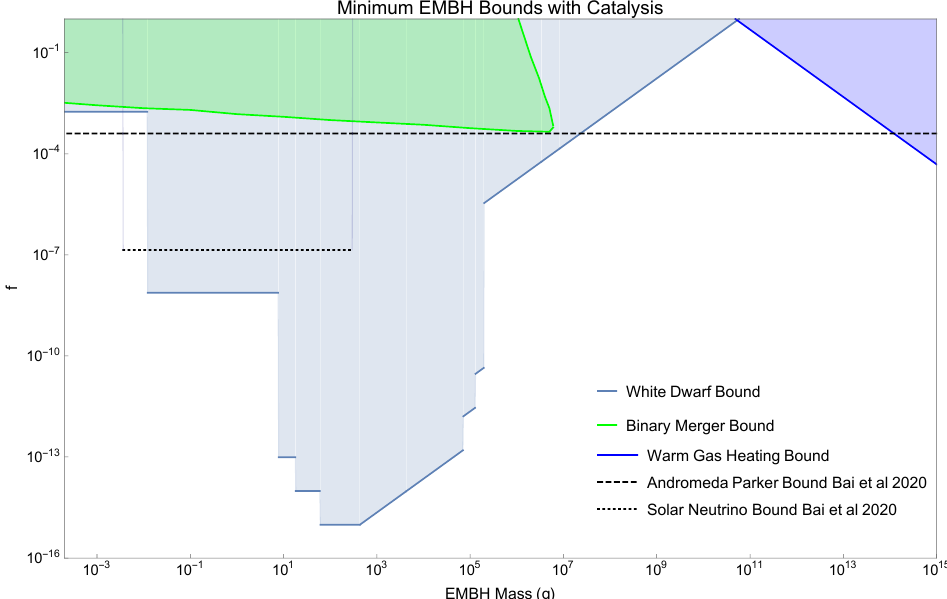
Figure 3 . The colored regions denote the minimum bounds on the EMBH abundance when catalysis effects are considered. The WD overheating and annihilation bounds are related by catalysis effects and marked as one in light blue. The bounds from overheating or destroying 1 M (cid:12) WDs dominate for EMBHs with M > 0 . 012 g. Lighter EMBHs cannot destroy a 1 M (cid:12) WD when they annihilate so overheating WD J0551+4135 is used to constrain those with M < 0 . 012 g. No physically reasonable catalysis cross section could prevent EMBHs with 7 g . M . 2 × 10 5 g from annihilating in 1 M (cid:12) WDs at all times, so the original annihilation bound remains in a somewhat weakened form. The bounds appear jagged because the catalysis effects were considered at discrete cooling temperatures and would vary smoothly if these effects were considered at arbitrary cooling temperatures and times. There are plausible catalysis cross sections that prevent EMBH annihilation outside of this mass range, and so bounds come from WD heating instead. Bounds from gas heating and binary mergers are unaffected by catalysis and are described in sections 3.1 and 3.3, respectively. Constraints derived in ref. [15] are shown in black for comparison and labeled Bai et al. 2020. The dashed line comes from a Parker bound applied to the Andromeda Galaxy (see section 3.4). The dotted line comes from energetic neutrinos produced from EMBH annihilations in the Sun (see section 4.4). We cut this bound off for EMBHs with M > 300 g because convection in the Sun suppresses their annihilation